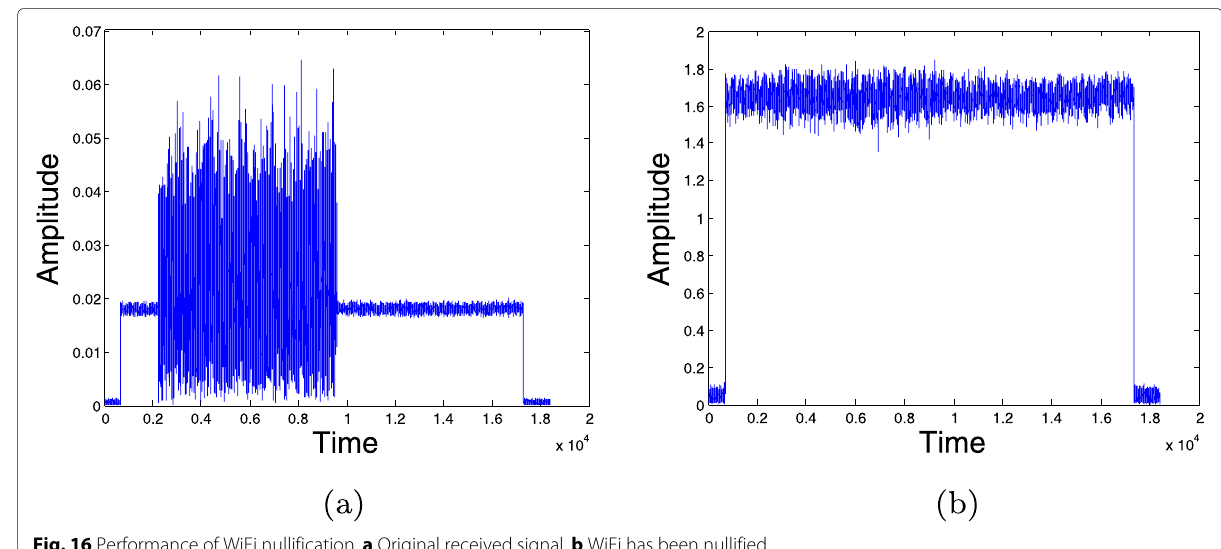
Fig. 16 Performance of WiFi nullification. a Original received signal. b WiFi has been